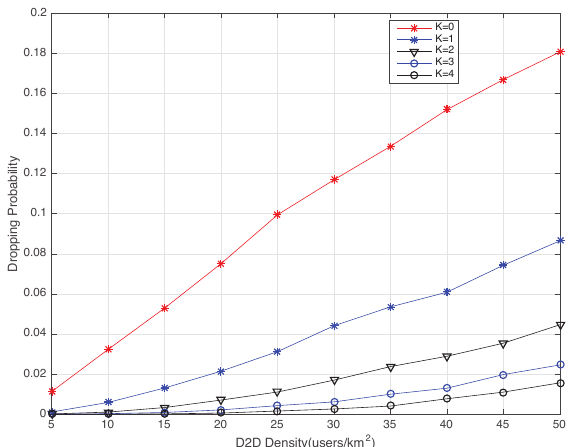
Figure 5. The dropping probability for D2D communication under different retransmission times K .